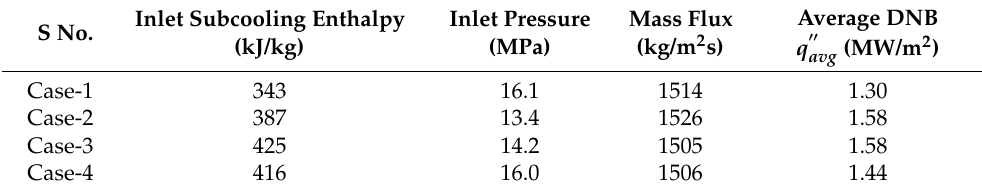
Table 3. Benchmark data (for square